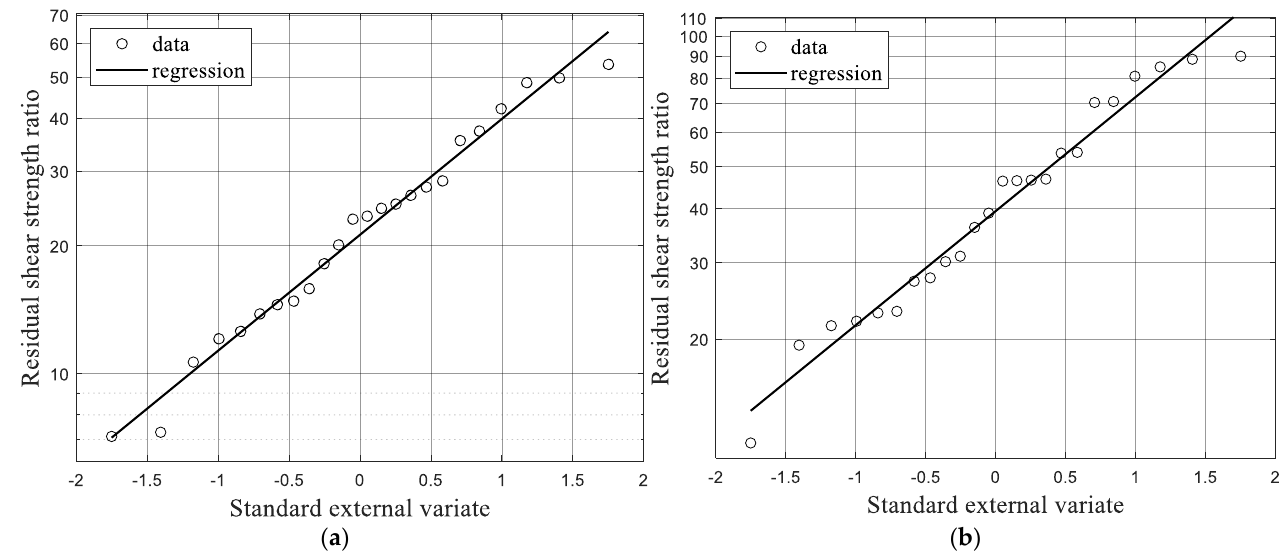
Figure 13. Cyclic energy dissipations on the log-normal probability paper. ( a ) 785 and ( b ) 1010 kN. Table 19. Probabilistic models of energy dissipation per repeated load. Load (kN) Mean (kN·mm) COV Load (kN) Mean (kN · mm)